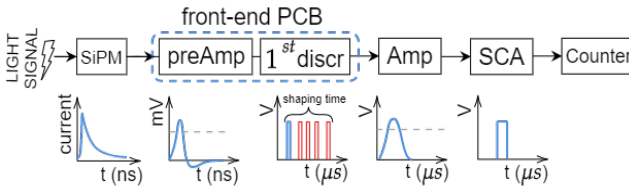
Fig. 3. Electronics and signal treatment of the miniature neutron scintillator, from light collection to neutron counting.